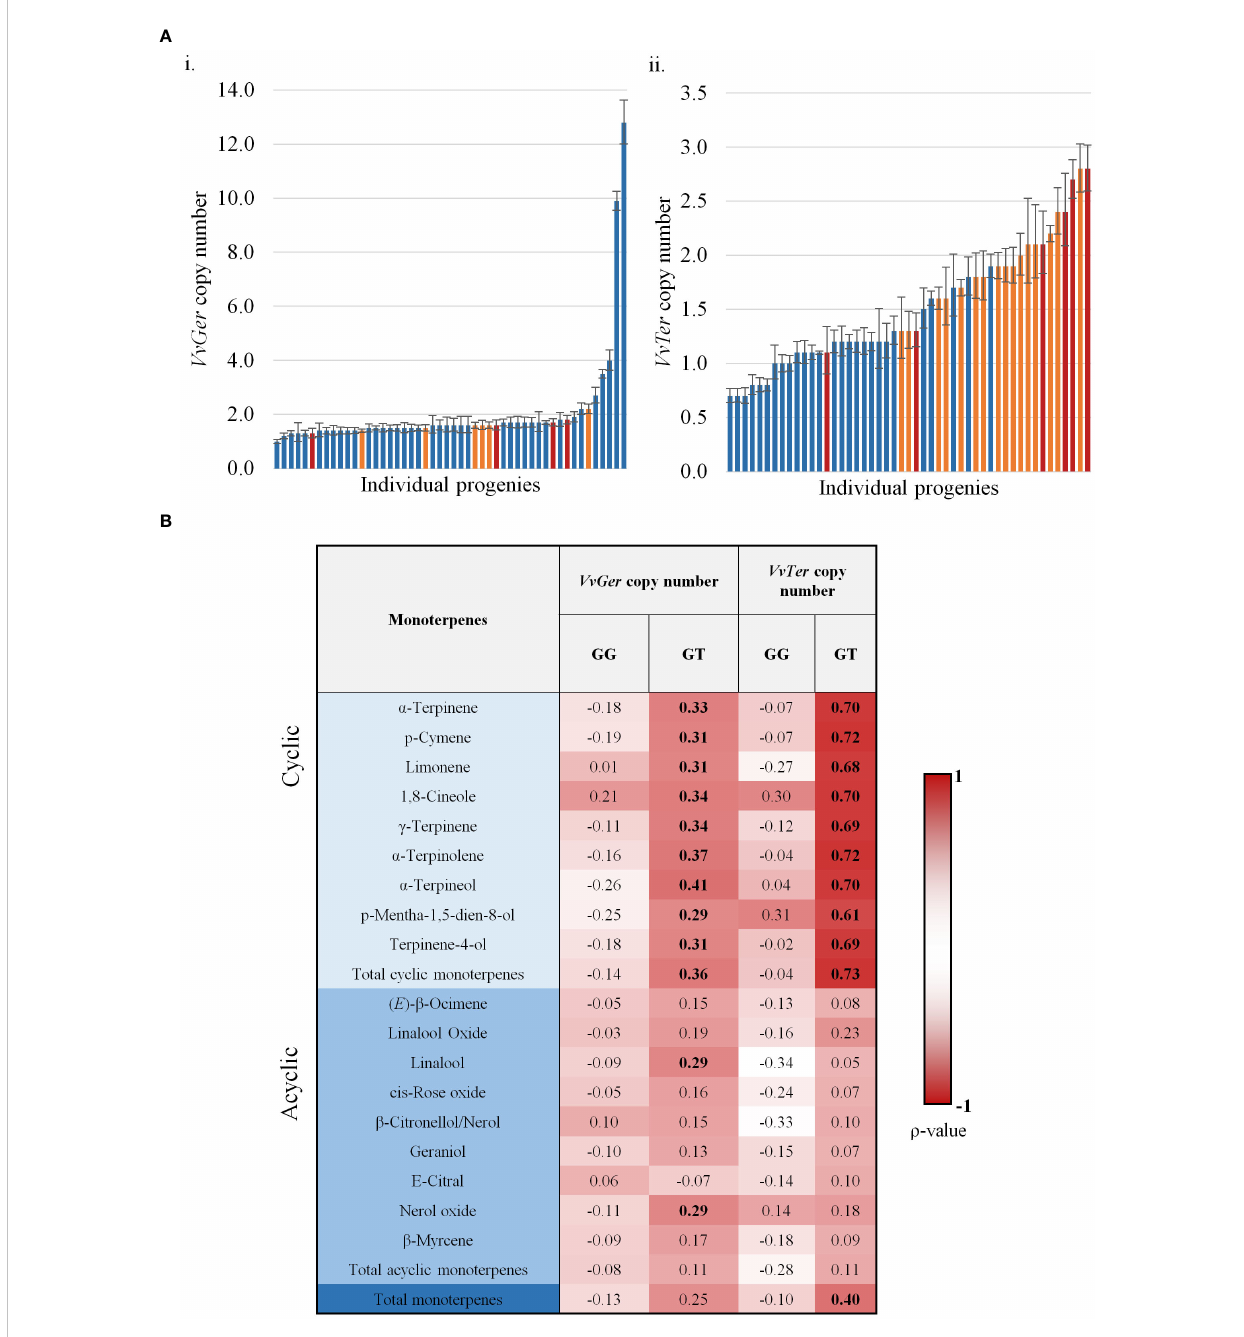
FIGURE 8 (A) The copy number of VvGer (i) and VvTer (ii) in progenies with the VvDXS1 SNP. Progenies were binned for low (blue), moderate (yellow) and high (red) geraniol (i) or total cyclic monoterpene (ii) content. n = 3; error bars represent standard error. (B) Spearman ’ s correlation between relative gene copy number (VvGer and VvTer) and monoterpenes. Correlation between gene copy number and monoterpenes were analysed separately for progeny with the VvDXS1 SNP (GT) and without the SNP (GG). Correlation values in boldface were statistically signi fi cant; p <